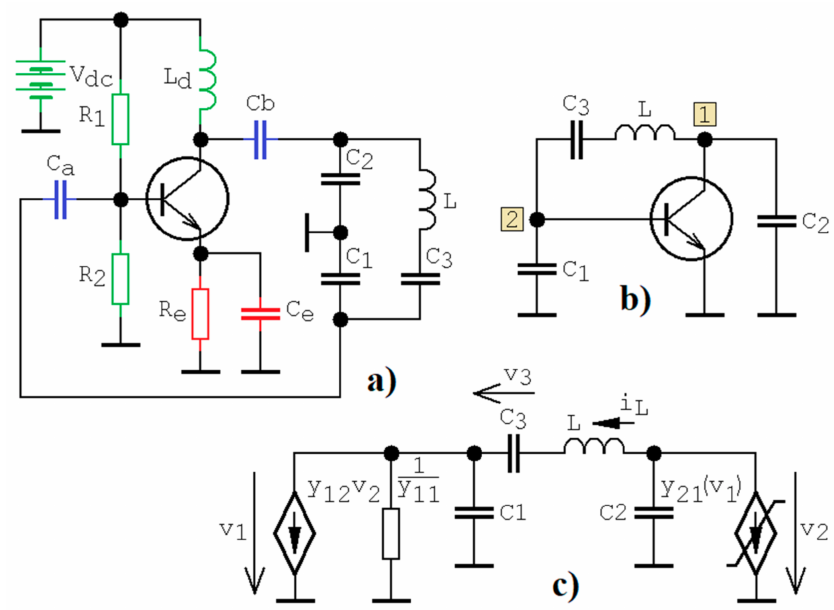
Figure 1. Clapp oscillator: ( a ) standard complete topology including biasing circuits, ( b ) simplified structure for quasilinear analysis, and ( c ) network with nonlinear model of bipolar